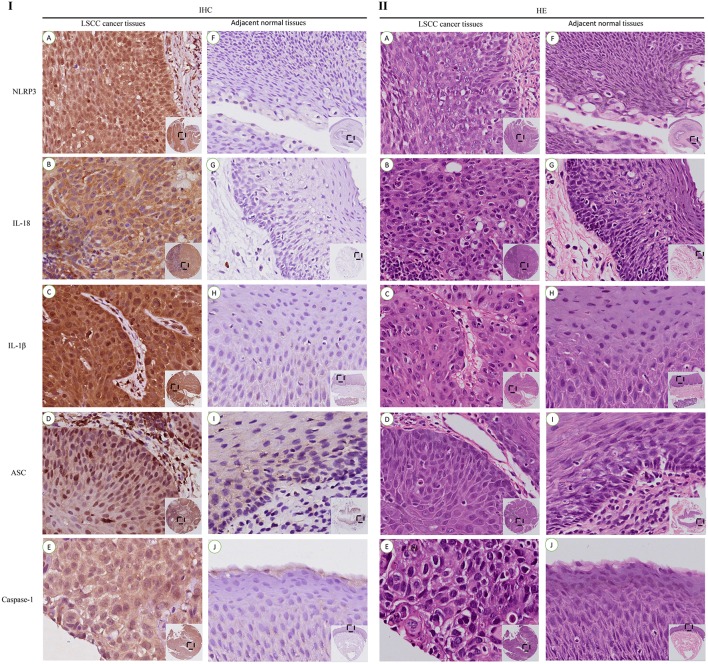
IHC staining and corresponding hematoxylin and eosin (HE) staining of NLRP3 inflammasome expression in LSCC tissues and adjacent normal tissues (200x).IHC staining of the NLRP3 inflammasome in LSCC tissues (I): (A) NLRP3; (B) IL-18; (C) IL-1β; (D) ASC; (E) Caspase-1. Staining of the NLRP3 inflammasome in the adjacent normal tissues (I): (F) NLRP3; (G) IL-18; (H) IL-1β; (I) ASC; (J) Caspase-1. HE Staining of the NLRP3 inflammasome in the LSCC tissues (II): (A) NLRP3; (B) IL-18; (C) IL-1β; (D) ASC; (E) Caspase-1. HE Staining of the NLRP3 inflammasome in the adjacent normal tissues (II): (F) NLRP3; (G) IL-18; (H) IL-1β; (I) ASC; (J) Caspase-1.